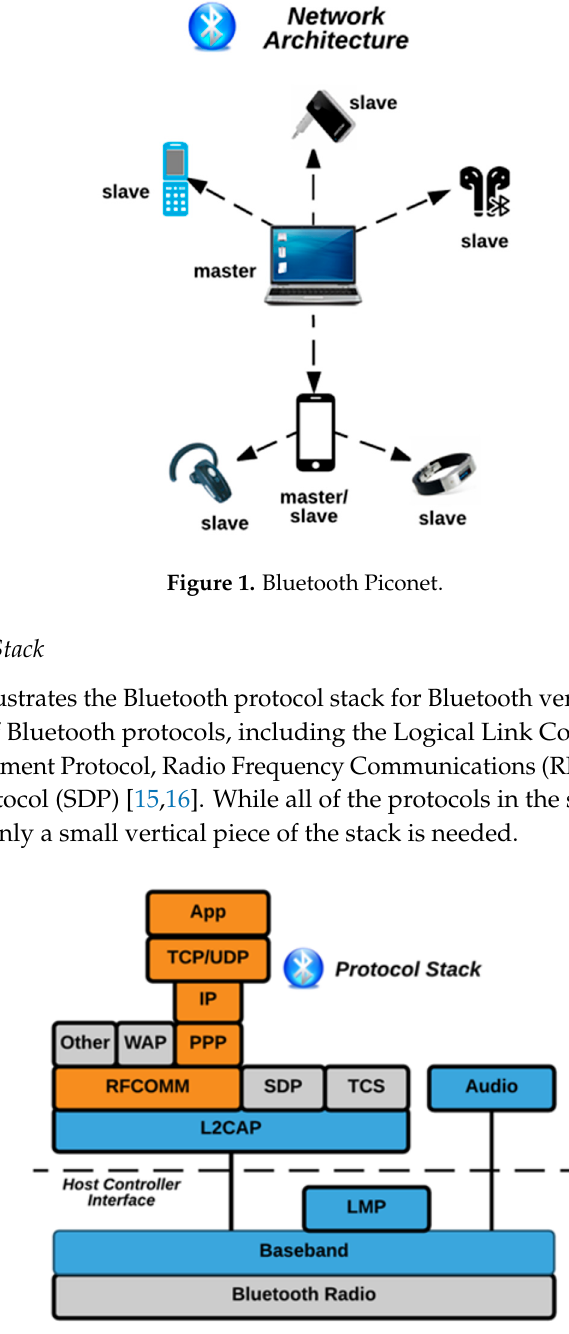
Figure 2. Bluetooth Protocol Stack (Bluetooth 1, 2, and 3).